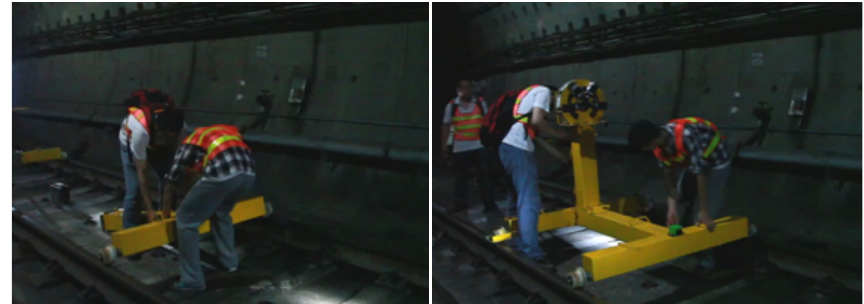
Figure 10. Assembling the device during the on-site application.